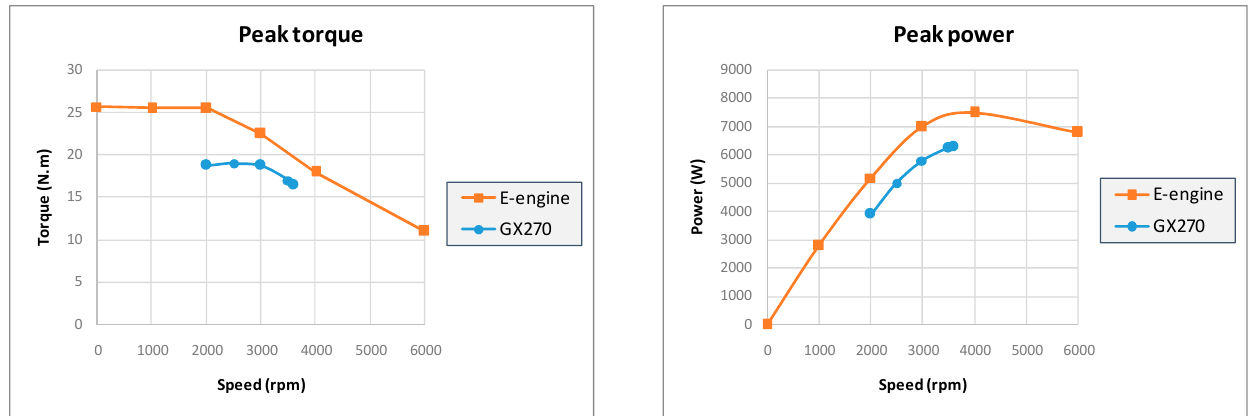
Figure 13. Peak performance in measurement at 42 Vdc of E-engine and comparison with ICE Honda GX270.